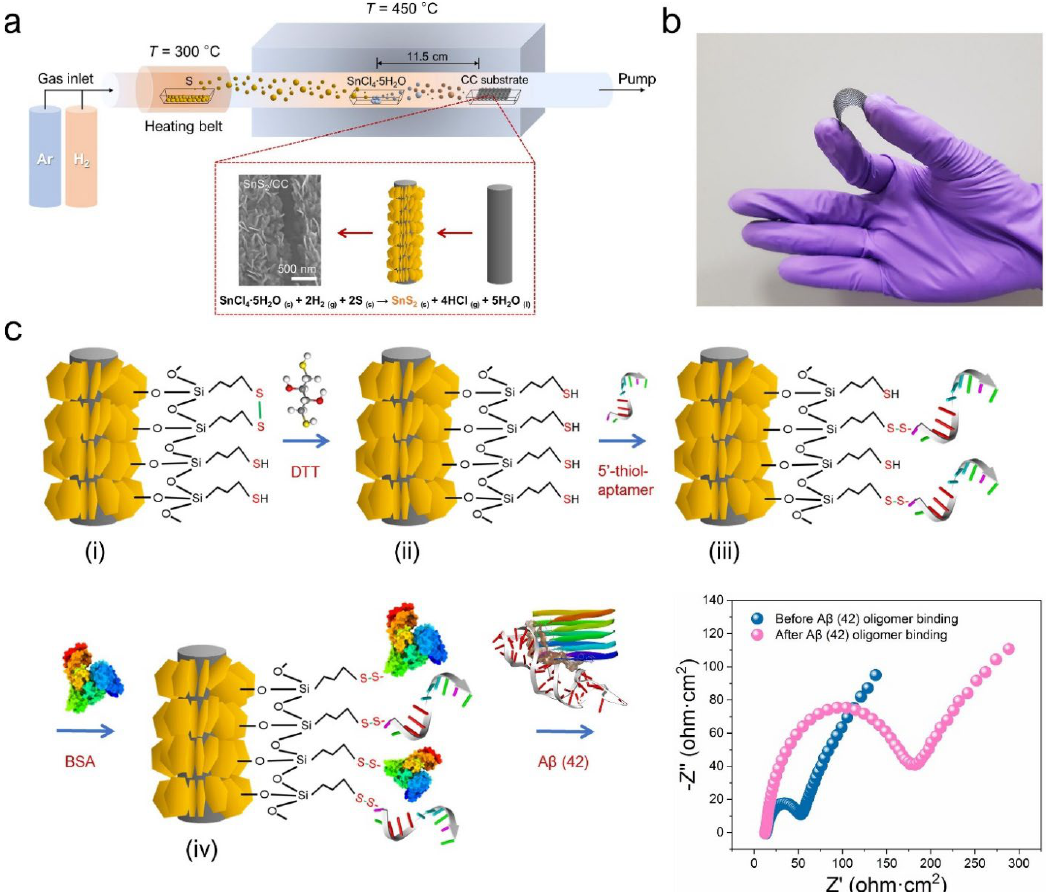
Figure 2. ( a ) Synthesis of tin disulfide NSs on CC, ( b ) flexibility of CC substrate, ( c ) stepwise fabrication of the proposed aptasensor and its electrochemical response. Reproduced with permission from